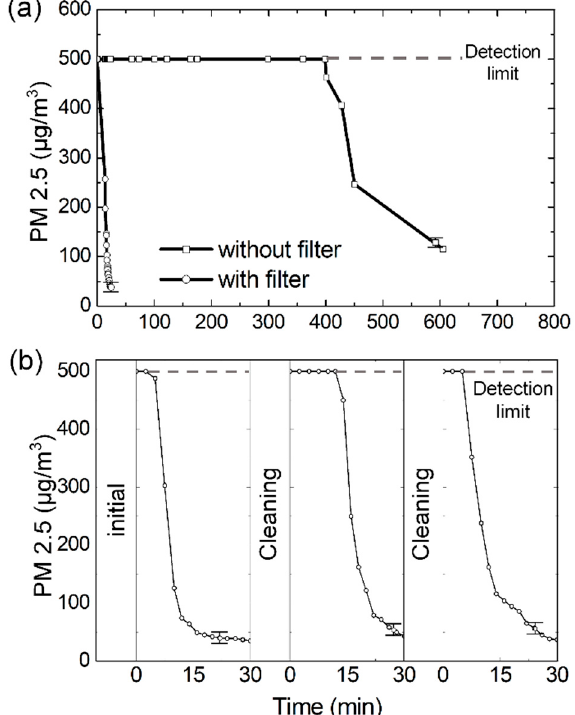
Figure 3. ( a ) Evolution of PM2.5 density as a function of time with and without the Kapton air filter. The detection limit was 500 µ g/m 3 . ( b ) The reliability and durability of the Kapton air filter after repeated washing.